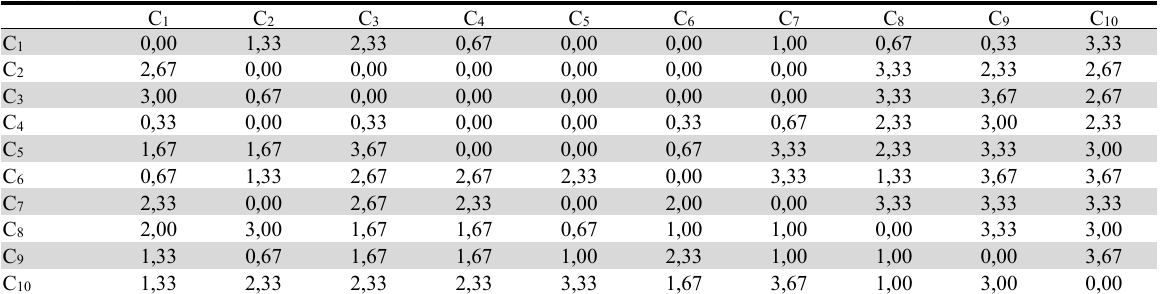
Aggregated direct relation